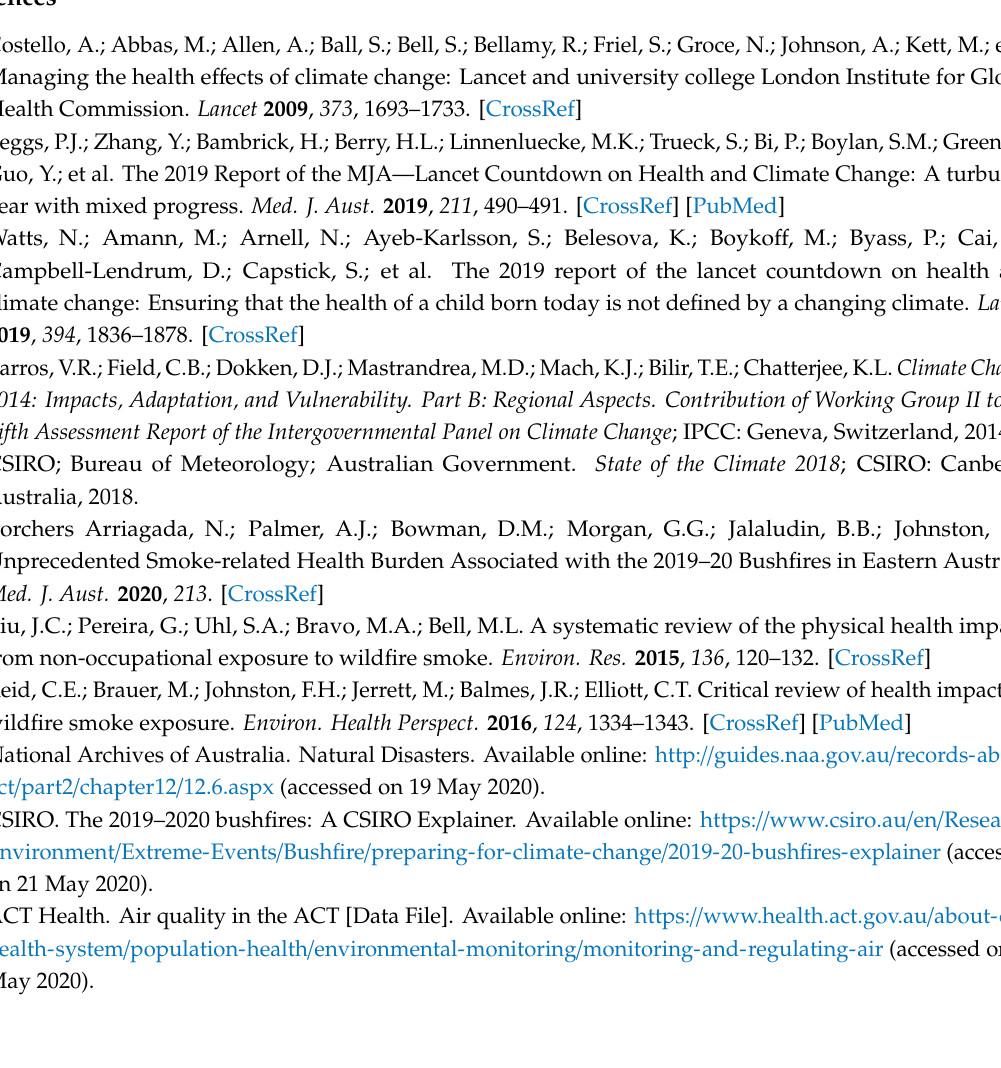
Figure S1: Variable Maps, Figure S2: Histograms of ED distance and natural log transformed ED distance, Figure S3: Histograms of GP distance and natural log transformed GP distance Table S1: Cluster analysis results all variables: Moran’s Index and Getis-Ord General G Statistic, Figure S4: Geographically Weighted Poisson Regression Local Coe ffi cients for Asthma, Figure S5: Geographically Weighted Poisson Regression Local Coe ffi cients for